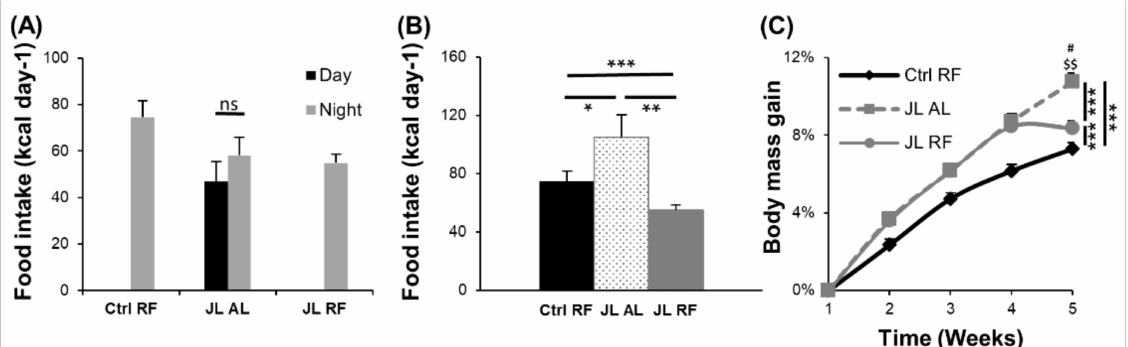
Figure 3. Effect of time-restricted feeding on food intake and body mass. ( A ) Day/night food intake pattern of control mice fed a TRF diet (Ctrl RF, N = 48), jetlagged mice fed ad libitum (JL AL, N = 48), and jetlagged mice fed a TRF diet (JL RF, N = 48) at week 4. ( B ) Total 24 h caloric intake in Ctrl RF (N = 48), JL AL (N = 48), and JL RF (N = 48) mice at week 4. ( C ) Percentage increase in body mass in Ctrl RF (N = 48), JL AL (N = 48), and JL RF (N = 48) mice. Data are